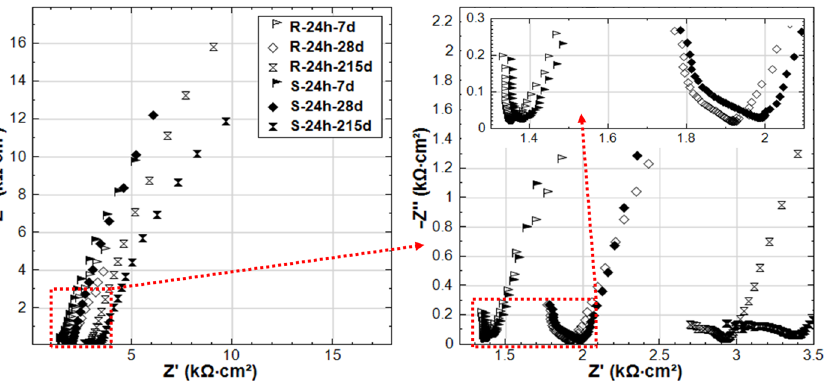
Figure 8. EIS responses overlay in Nyquist format of R-24h and S-24h (R-24h: Reference, S-24h: Stray Current, 24h-cured specimens treated in water).